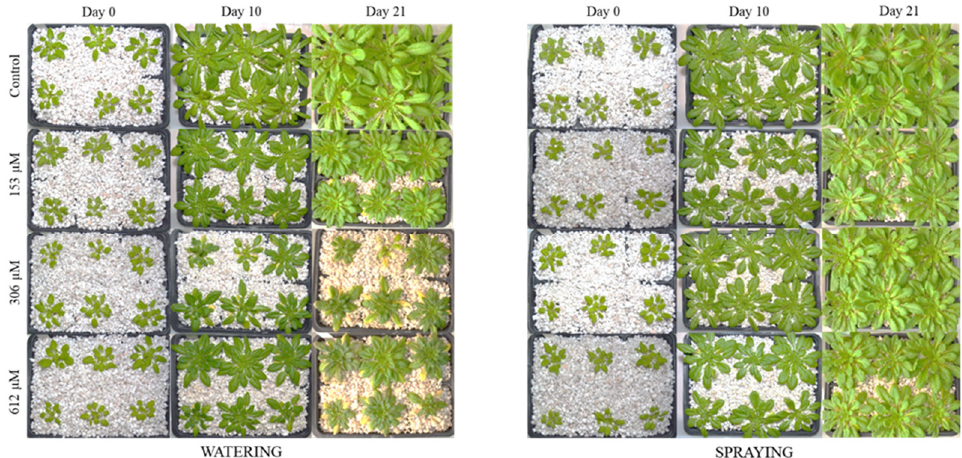
Figure 3. Adult A. thaliana plants watered and sprayed with different norharmane concentrations (0, 153, 306 and 612 µM) after 0, 10 and 21 days of treatment.